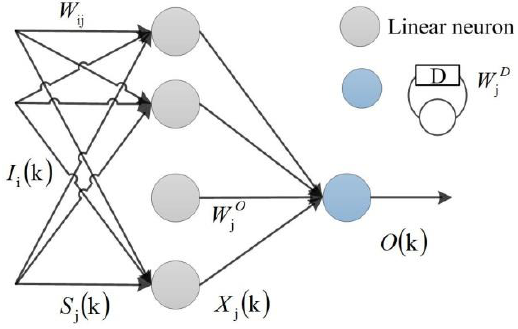
Figure 4. Diagonal recursive neural network structure.